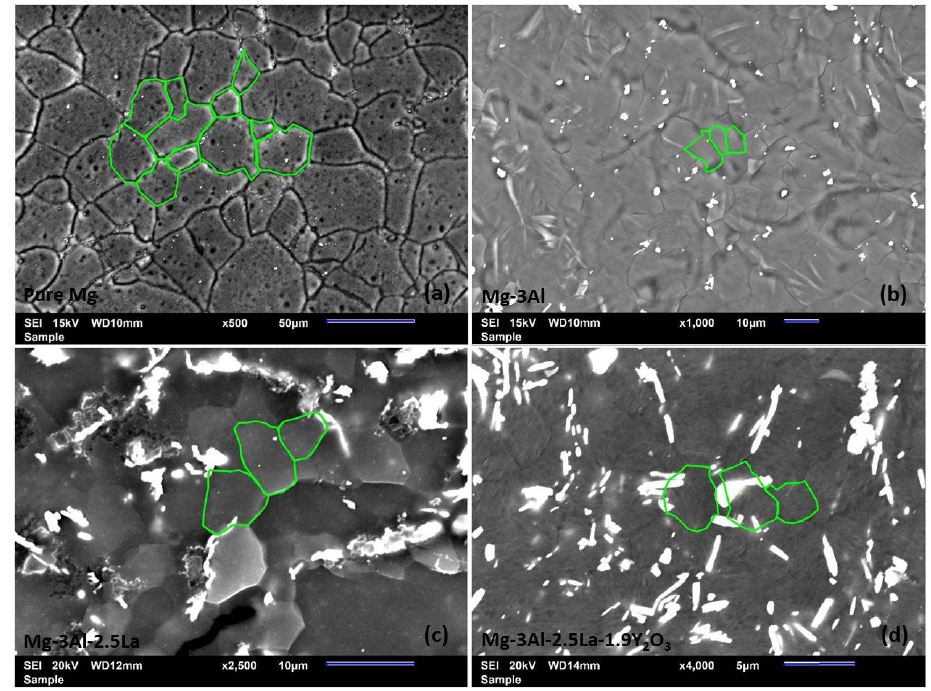
Figure 1. Scanning Electron Microscopic (SEM) micrographs of ( a ) pure Mg, ( b ) Mg–3Al, ( c ) Mg–3Al– Figure 1.